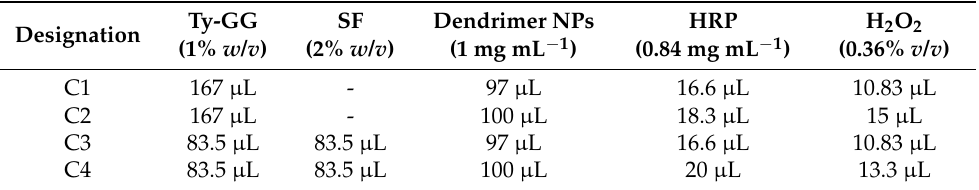
Table 1. Anti-TNF α Ab-CS/PAMAM loaded-Ty-GG and Ty-GG/SF hydrogels with different crosslinking